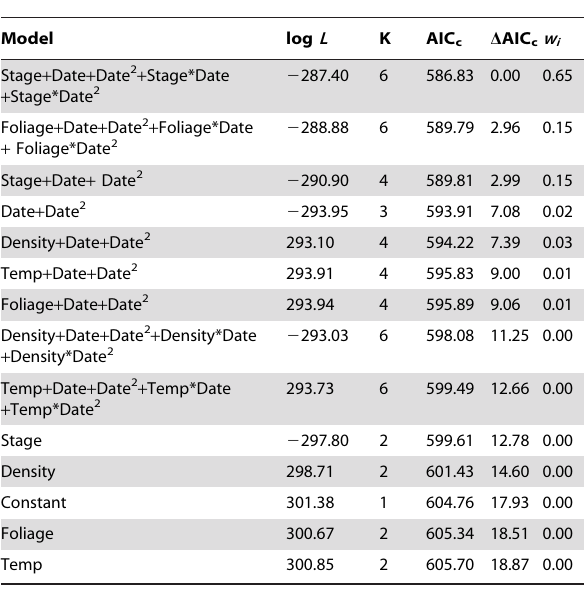
Table 3. Model selection results examining the effect of foliage phenology (Foliage), minimum energetic demand (Temp), developmental stage (Stage), and conspecific nest density (Density) on the risk of nest predation (1-Survival) for Dusky Flycatchers ( n= 167) from 2006 to 2008, Lake Tahoe,